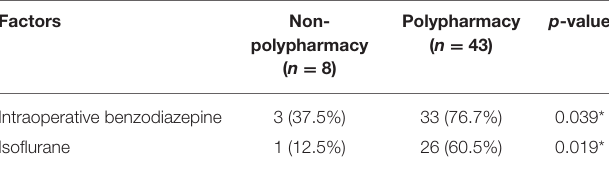
TABLE 7 | Prevalence of the independent factors that predict postoperative cognitive dysfunction (POCD) in older adult patients after major surgery compared between the non-polypharmacy and polypharmacy